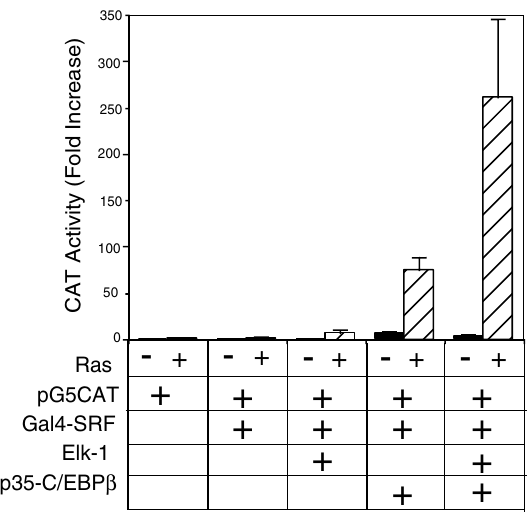
Figure 1 Elk-1 and p35-C/EBP β synergize in SRF dependent transacti- vation of a GAL4 reporter construct. NIH 3T3 cells were transfected with 1 µ g of pG5CAT alone, with 0.5 µ g of pGAL4-SRF, or with 0.5 µ g of pGAL4-SRF and 0.5 µ g of pCMV-LAP (encoding p35-C/EBP β ) and/or 0.5 µ g of pCMV- Elk-1 as indicated, in the absence and presence of 1 µ g pCMV-Ras.V12. Total DNA in each transfection was adjusted to 3.5 µ g with pUC19. Cells were serum deprived for 40 h prior to harvesting. CAT activity was measured as previously described [33]. Data are the average of 14 determinations, and error bars represent standard error.